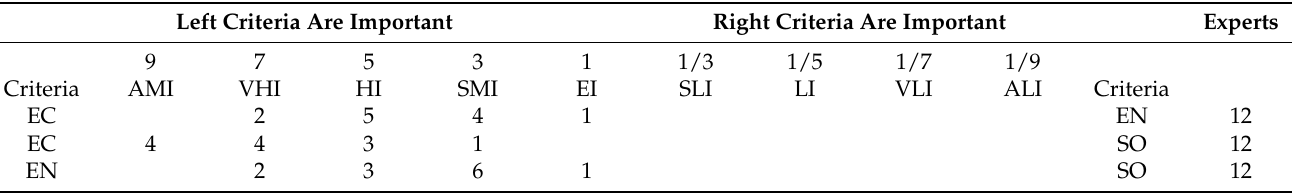
Table 8. Initial Comparison Matrices’ main criteria.